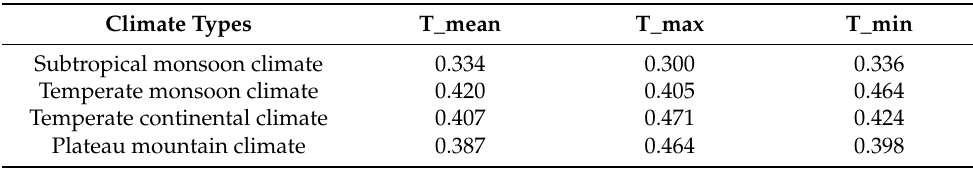
Table 2. Rates of increase of annual ERA-Interim temperature data for the four different climate zones within Gansu Province during the period 1979–2017 ( ◦ C/10a).